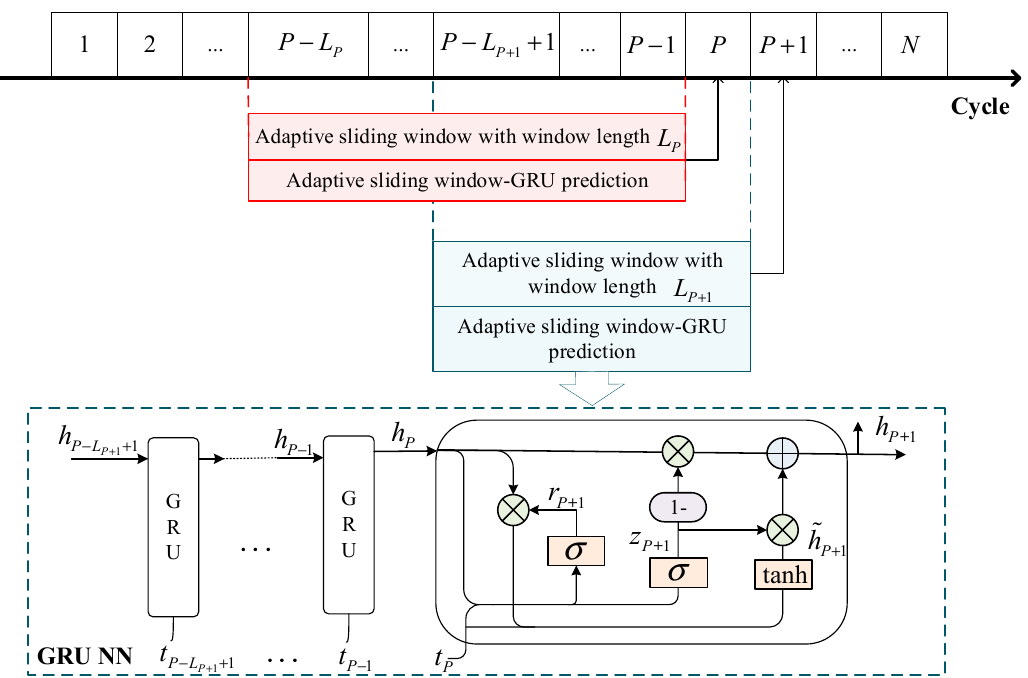
Figure 4. The architecture of proposed ASWGRU.